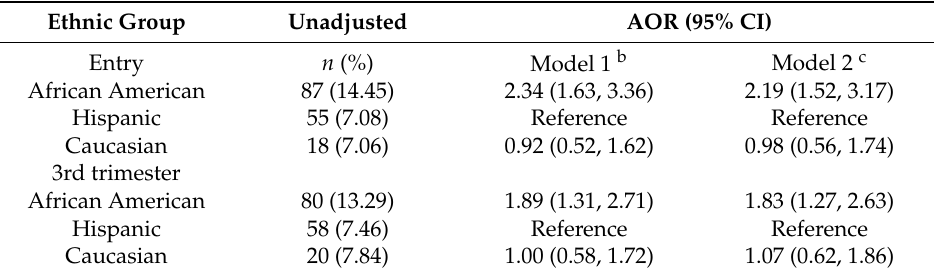
Table 6. Association of combination of low adiponectin and high resistin with ethnicity a